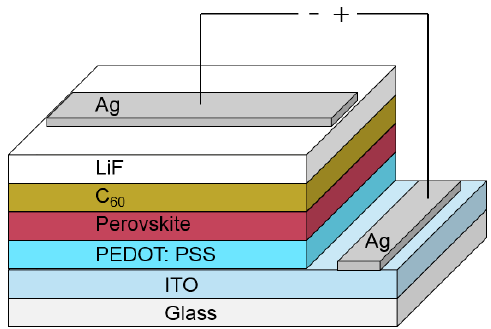
Figure 1. In this figure, a schematic of the used device structure containing all layers is presented. The layer thicknesses are not in scale. The different layer thicknesses are presented in Section 4.2 for optimized solar cell